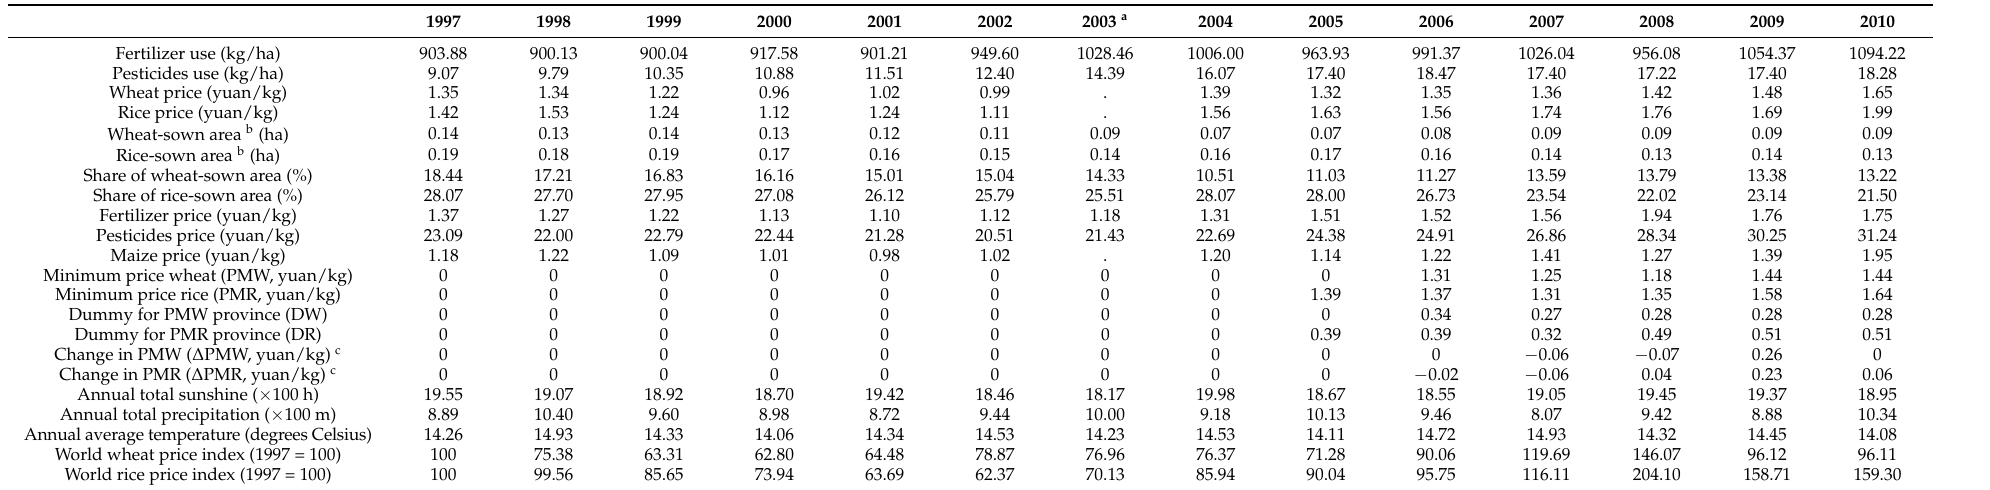
Table 2. Mean values of variables used in empirical